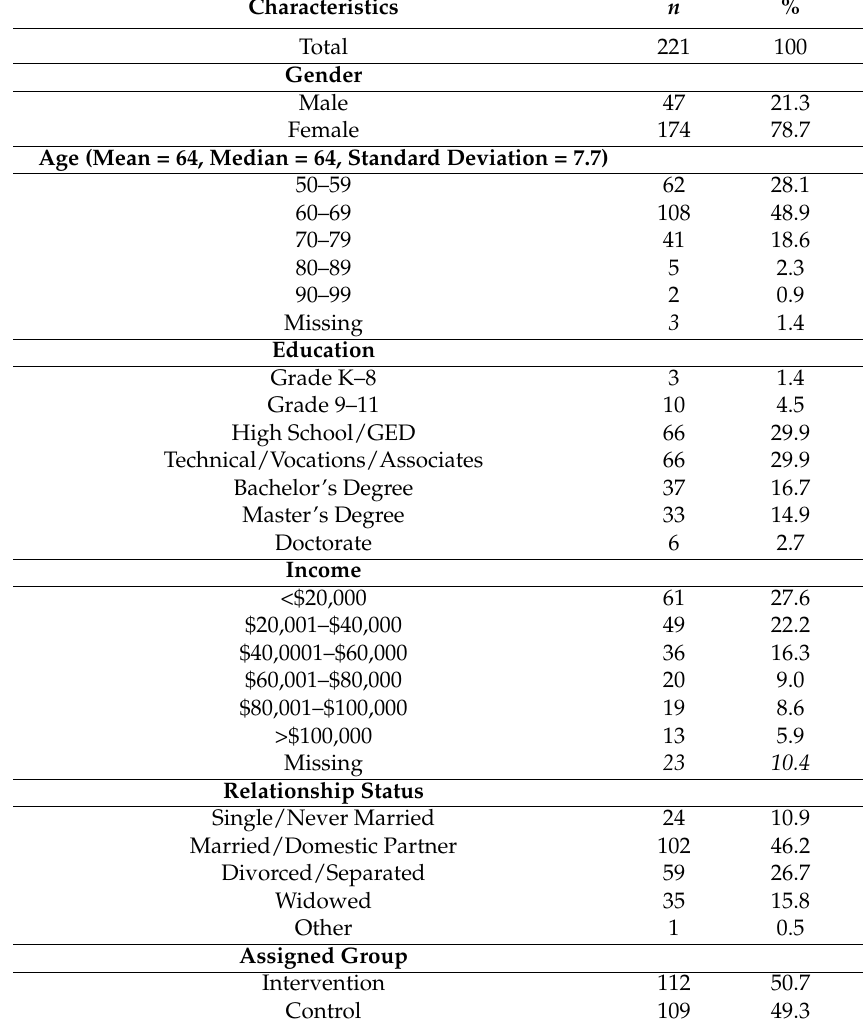
Table 1. Sample characteristics.